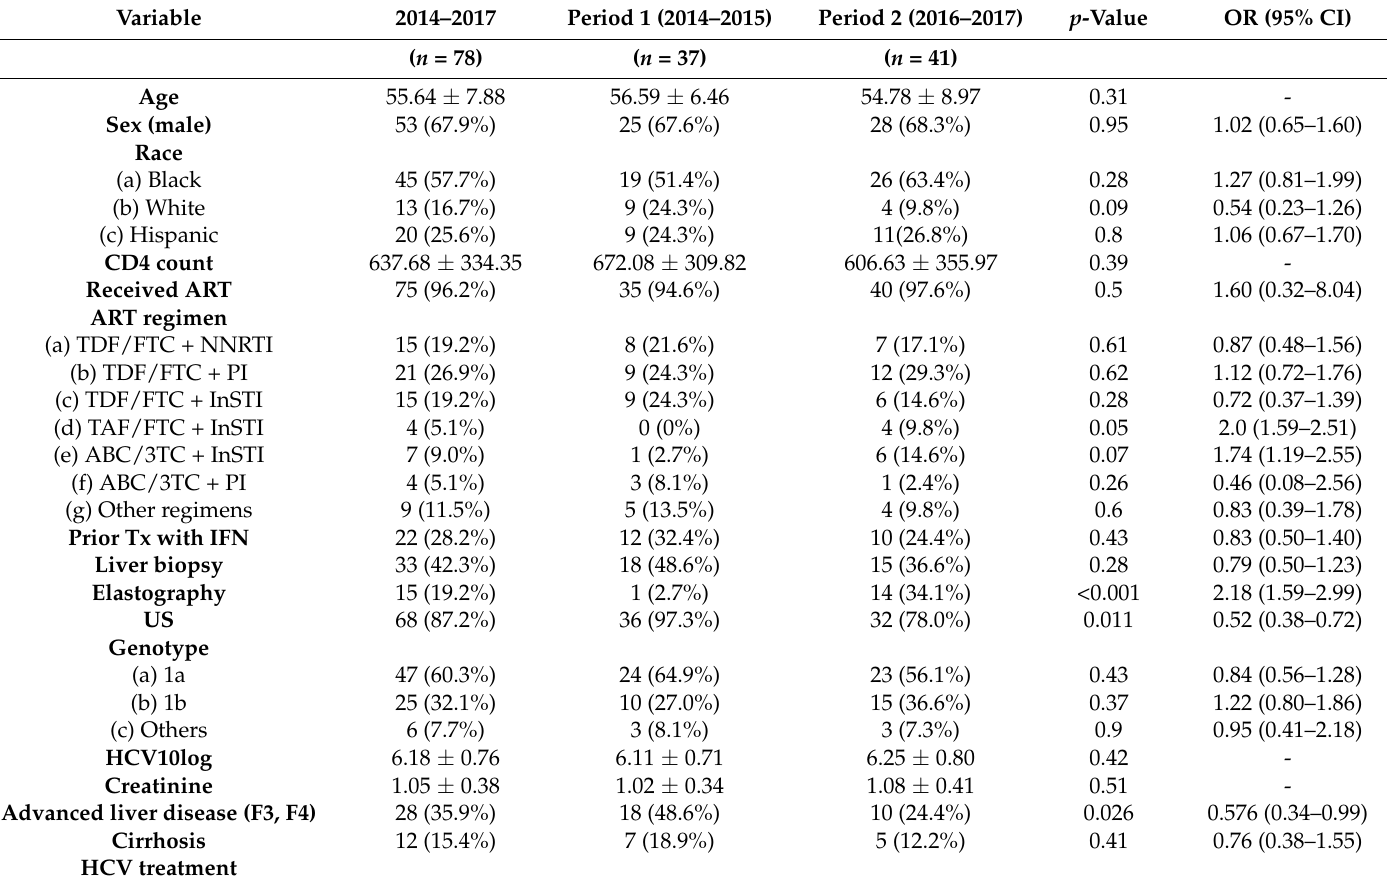
Table 1. Clinical and treatment characteristics of human immunodeficiency virus (HIV)/hepatitis C (HCV) coinfected patients and comparison by treatment period (periods 1 and